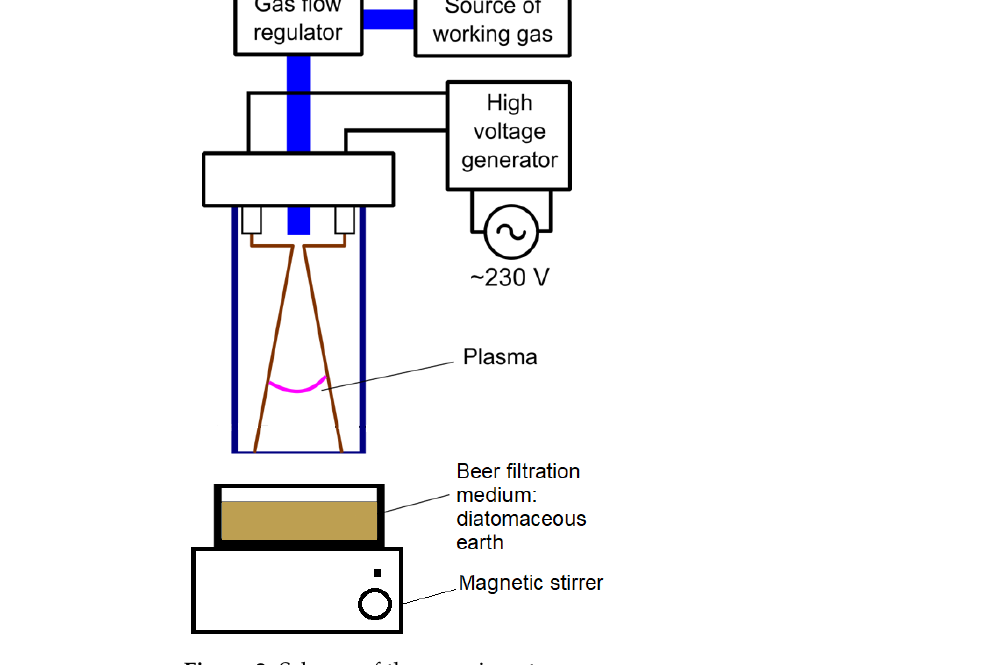
Figure 2. Scheme of the experiment.